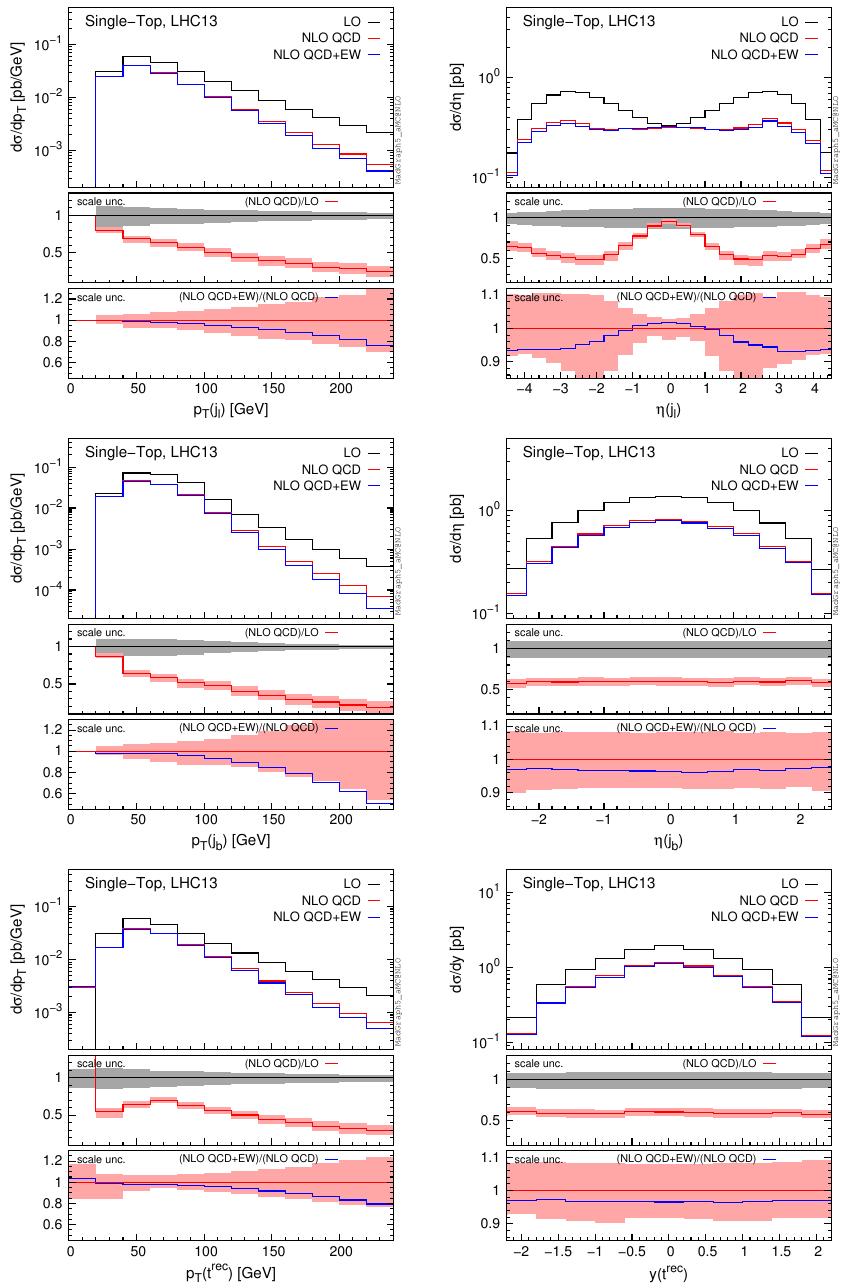
Figure 2 . LO, NLO QCD and NLO QCD+EW predictions for the transverse momentum (left) and rapidity (right) distributions of the light jet (top), b -jet (central) and reconstructed-top (bottom) for the Single-Top process.